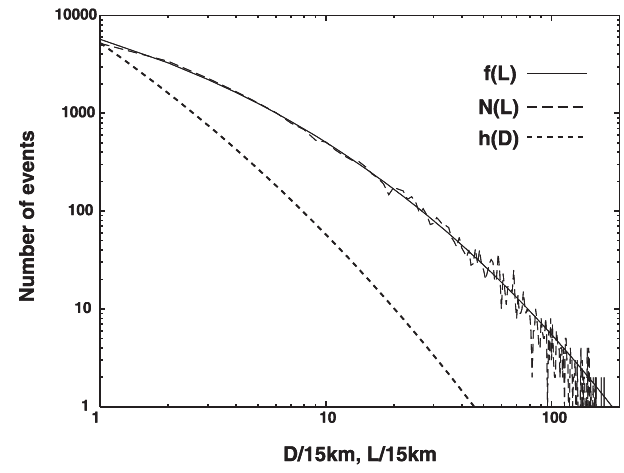
Fig. 3. As Fig. 1, together with a ‘‘true’’ size distribution, h (cid:133) D (cid:134) , of circular ice-supersaturated regions, and a resulting path length distribution, f (cid:133) L (cid:134) , that fits the original path length distribution N (cid:133) L (cid:134) reasonably well. h (cid:133) D (cid:134) is a generalised gamma-distribution with